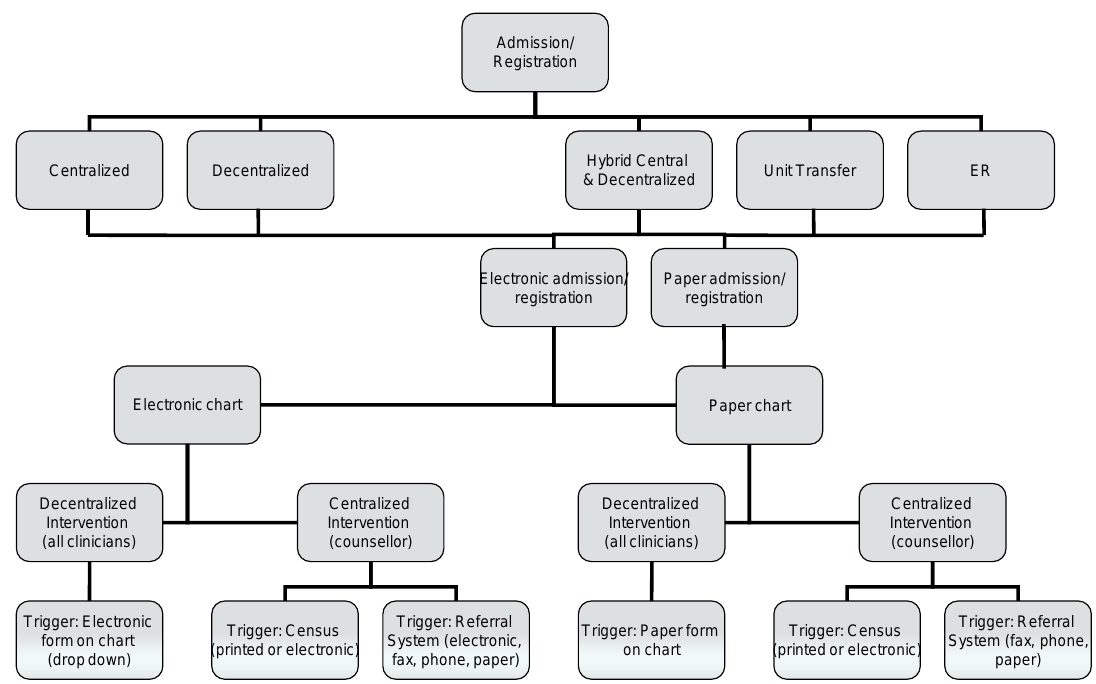
Figure 2. Decision tree to determine the process and forms needed to trigger a tobacco cessation